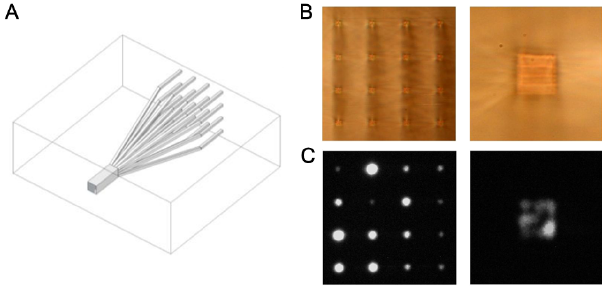
Figure 7: (A) Ultrafast laser inscribed photonic lantern with 16 ports arranged in a 4 × 4 matrix at the output and square multi-mode input. (B) Microscope images of the single-mode and multimode end-face of the lantern. (C) Corresponding near-field profiles at a wavelength of 1539 nm. With permission from [6]. Copyright 2011 The Optical